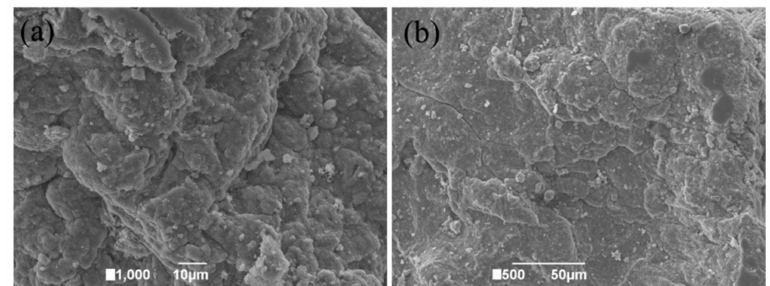
Figure 4. SEM image of MXCS/PAA at ( a ) 1000 × and ( b ) 500 × magnification.